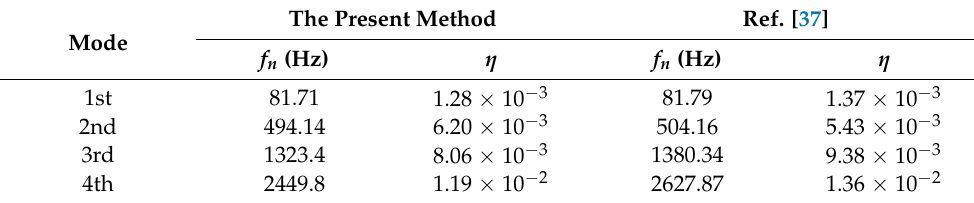
Table 3. Comparison of the results of the sandwich beam.